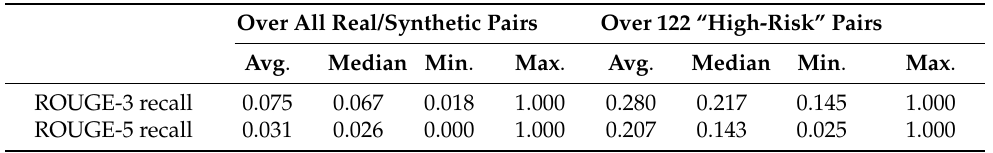
Table 8. Summary statistics for ROUGE-N recall over all real/synthetic document pairs and over the filtered subset of “high-risk” documents presented to participants in the user study.